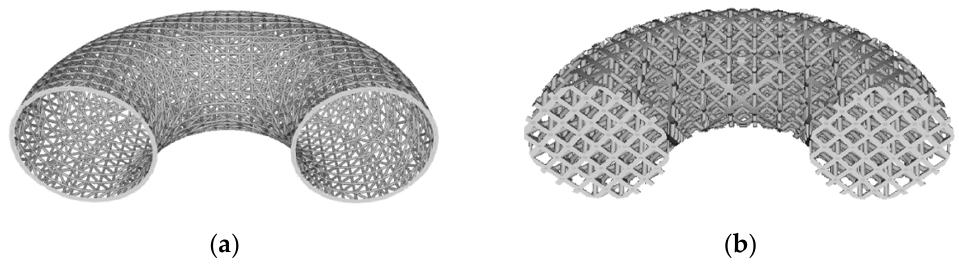
Figure 5. ( a ) Surface lattice, and ( b ) volume lattice.